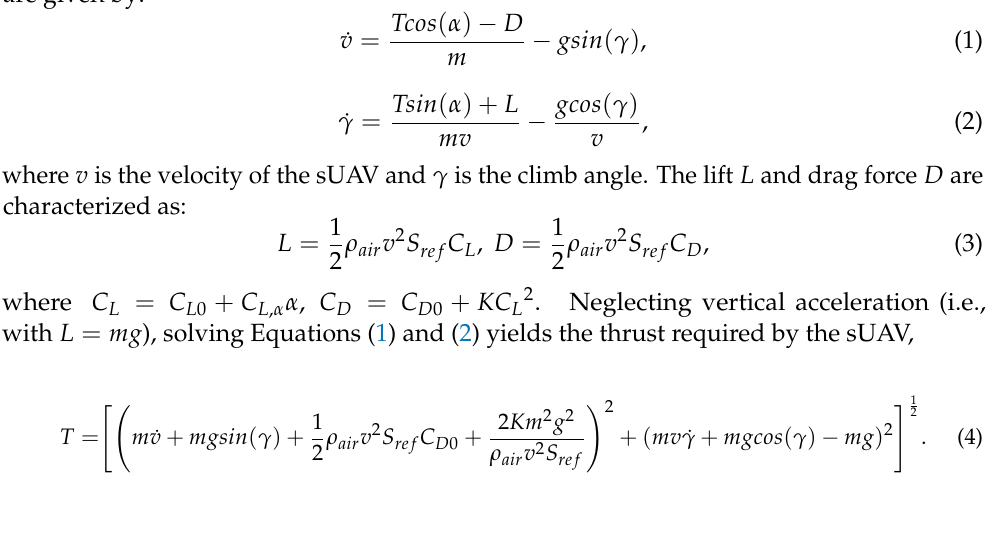
Power required by the sUAV Angular speed of the electric motor RPM Power generated by the propeller Propulsive